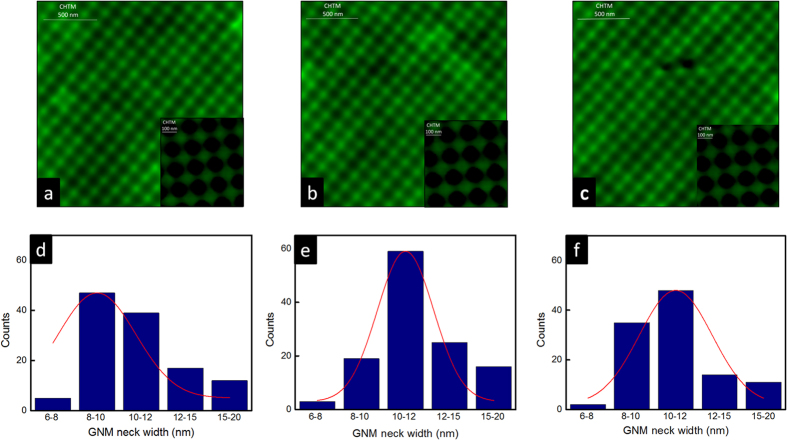
AFM images of the narrowest GNM and statistical analysis of the neck widths.(a–c) AFM images acquired from three different spots on the GNM sheet etched for 80 seconds. Insets in a–c, show high-magnification images. (d–f) Histograms of neck widths for a–c fitted with a Gaussian function.